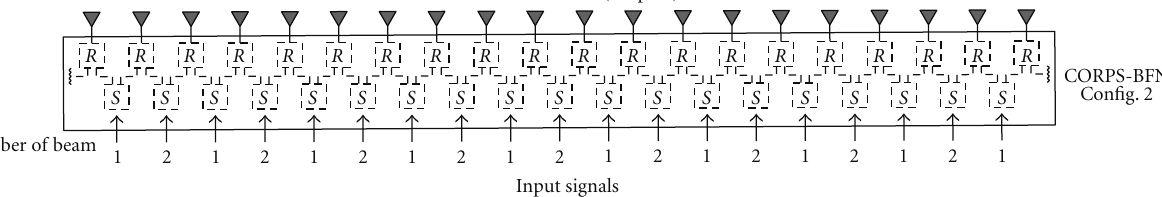
Figure 3: Configuration 2 of CORPS-BFN with 19 feeding ports and 20 antenna elements in a linear array considering 10 inputs × 20 outputs for beam no. 1 and 9 inputs × 18 outputs form beam no. 2.